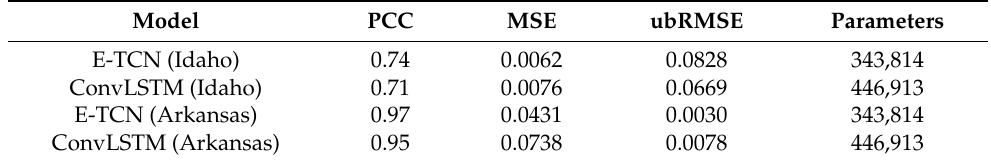
Table 6. Error metrics for the predicted soil moisture values and number of trainable